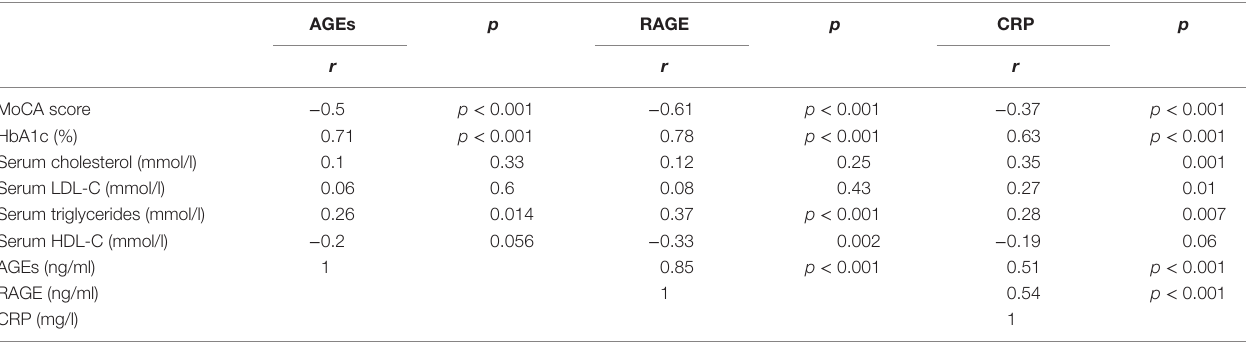
TaBle 3 | relationship of serum levels of ages, rage, and crP with other clinical indicators in group of diabetic elderly patients with Mci. ages p rage